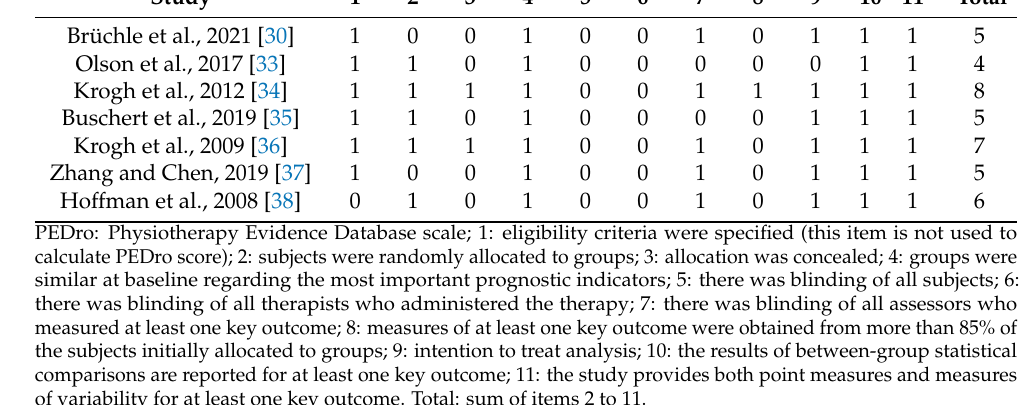
Table 4. PEDro scale of the studies included.